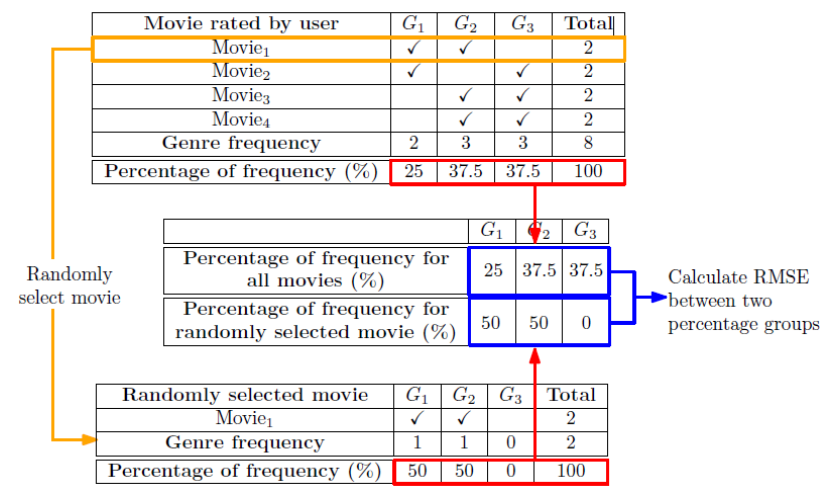
Figure 16. Procedure example of calculating error rates.